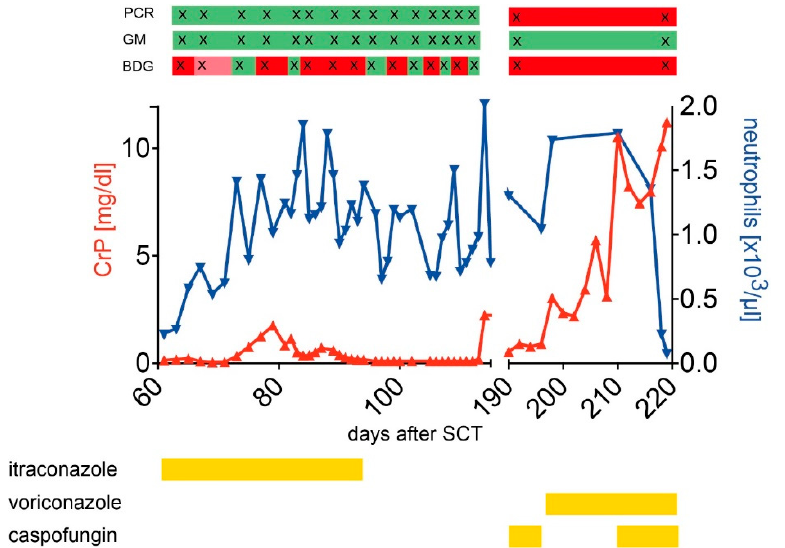
Figure 3. Medical history of a patient with several suspected pulmonary infections. Graph displays the course of C-reactive protein (CrP, red) and neutrophils counts (blue) over time, together with the results of the GM, PCR, and BDG assays (bars above the graph). For GM, PCR, and BDG assays, “red” indicates a positive test result, “green” a negative test result, “light red” an indeterminate result (only for BDG). Antifungal prophylaxis/treatment is outlined in yellow bars below the graph.